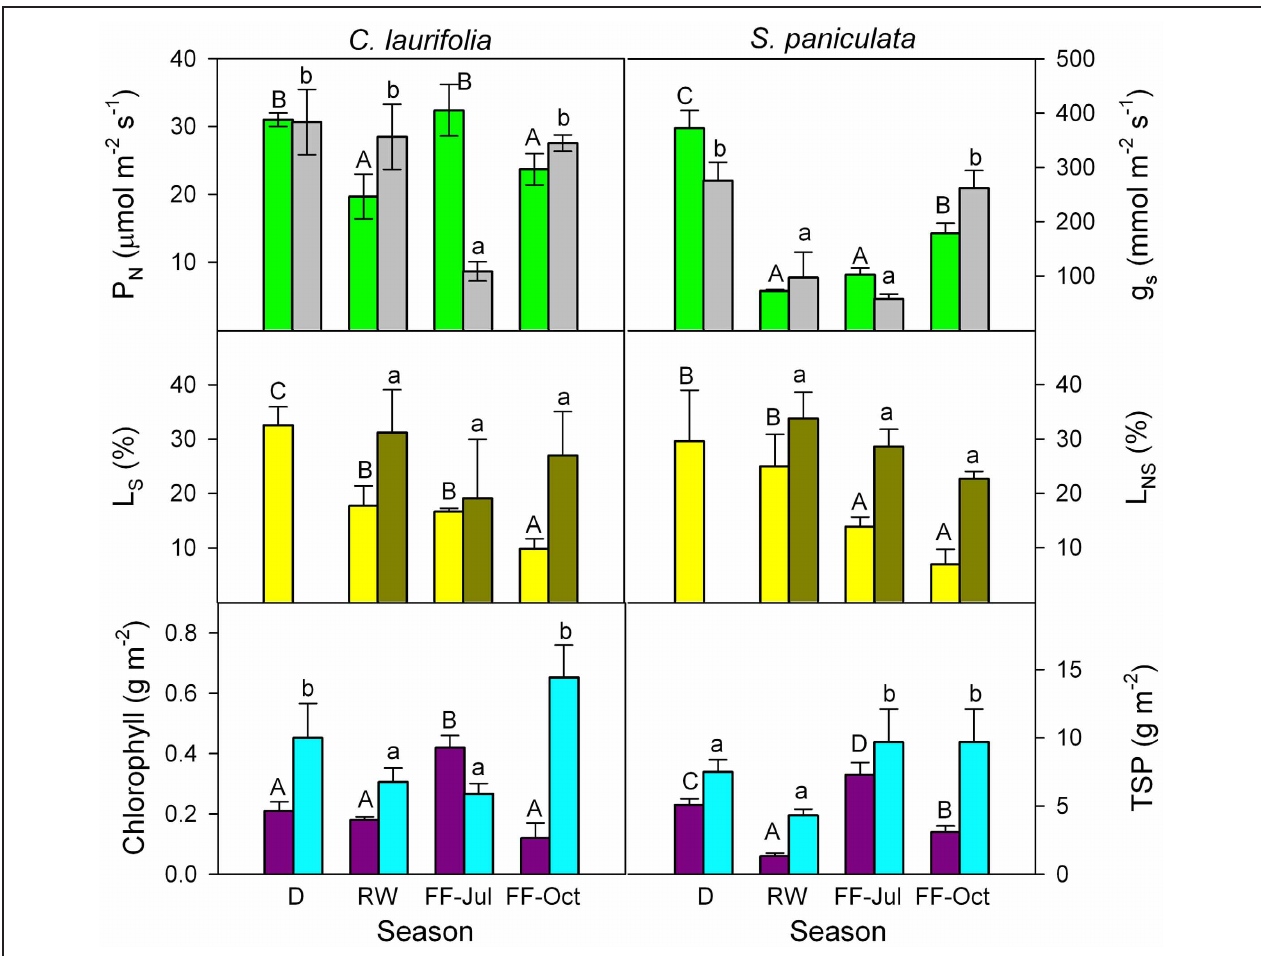
and total soluble protein (cyan) content of the species indicated. D, drainage; RW, rising-waters; FF-Jul, full flood in July; and FF-Oct, full flood in October. Modified from Herrera et al.